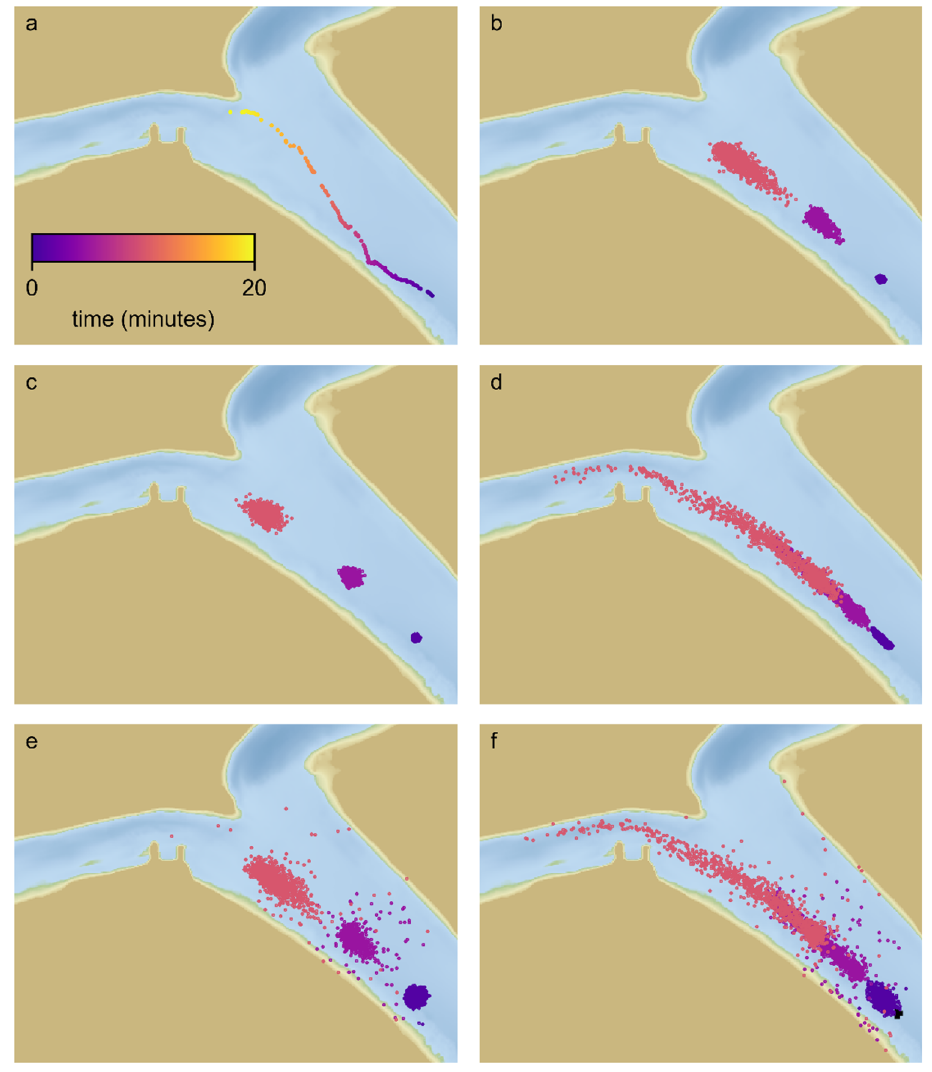
Figure 5. Observed and predicted positions for tag 7B4D: ( a ) position estimates of tag 7B4D and time from entry to acoustic array; ( b – f ) distributions of particles at 1 min (blue), 5 min (magenta) and 10 min (salmon) for; ( b ) passive; ( c ) surface-oriented; ( d ) rheotaxis; ( e ) CRW; ( f ) combination of surface-oriented, rheotaxis and CRW.